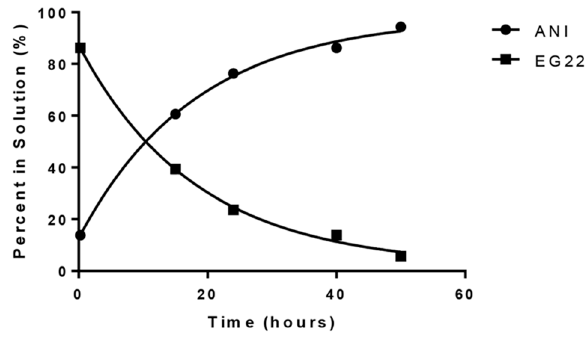
Figure 2. Formation of 4-amino-1,8-naphthalimide, ANI ( 7a ) in DMSO over time using ANI/(ANI + EG22) percent peak ratio and decay curve for EG22 ( 8a ) in DMSO over time using EG22/(ANI + EG22) percent aromatic peak ratio.